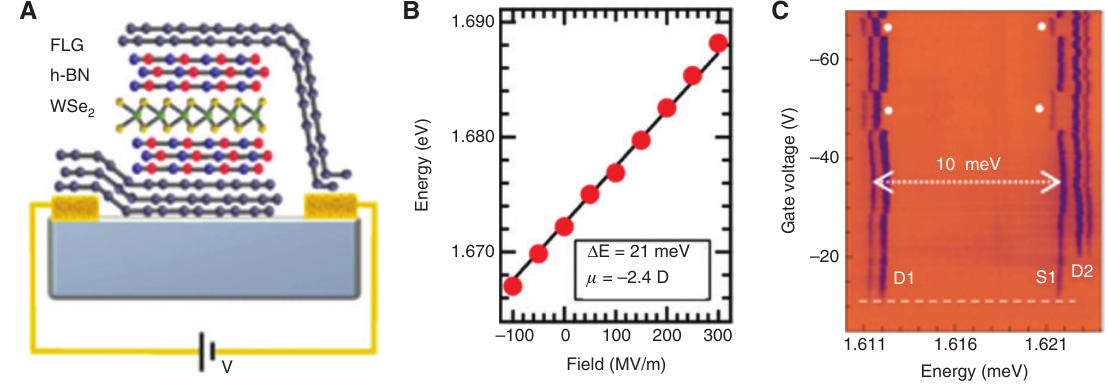
Figure 8: Voltage controlled emission. (A) Illustration of a van der Waals heterostructure device used for the electrical manipulation of quantum emitters in 2D materials. (B) Stark of electrostatic doping via a gate voltage (Vg) from a typical QD in WSe . S1 and D1 have correlated spectral jittering patterns (highlighted by 2 solid symbols) and the same turn-on voltage (dashed line), respectively. As a result, they are assigned to the same QD groups. The